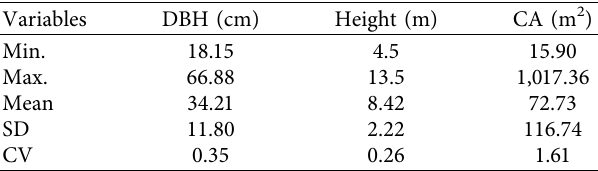
Table 1: Dendrometric description of trees sampling of Balanites aegyptiaca